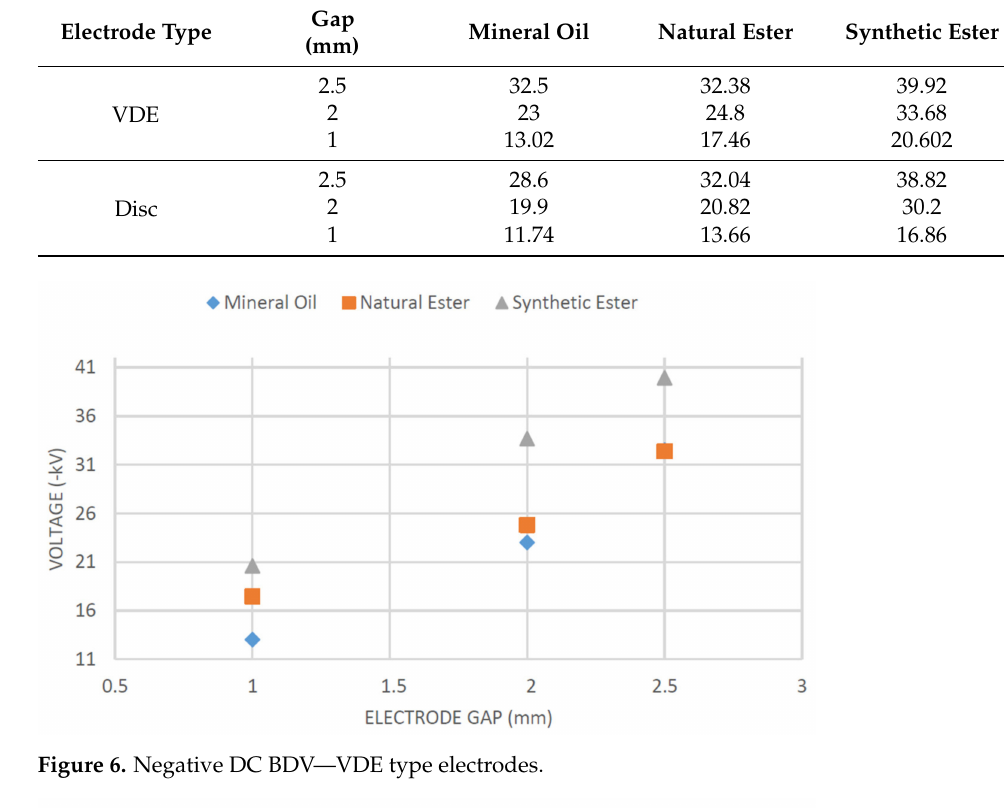
Figure 6. Negative DC BDV—VDE type electrodes.